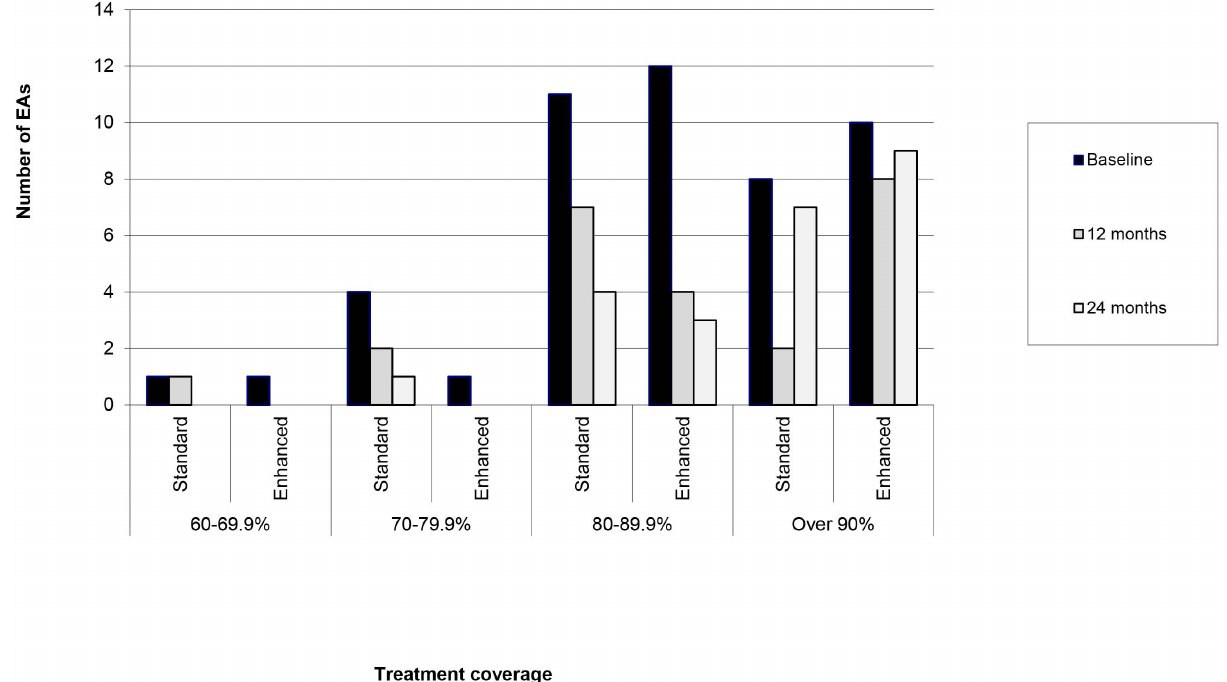
Figure 3. Treatment coverage in 0–9 s according to allocation and time point.